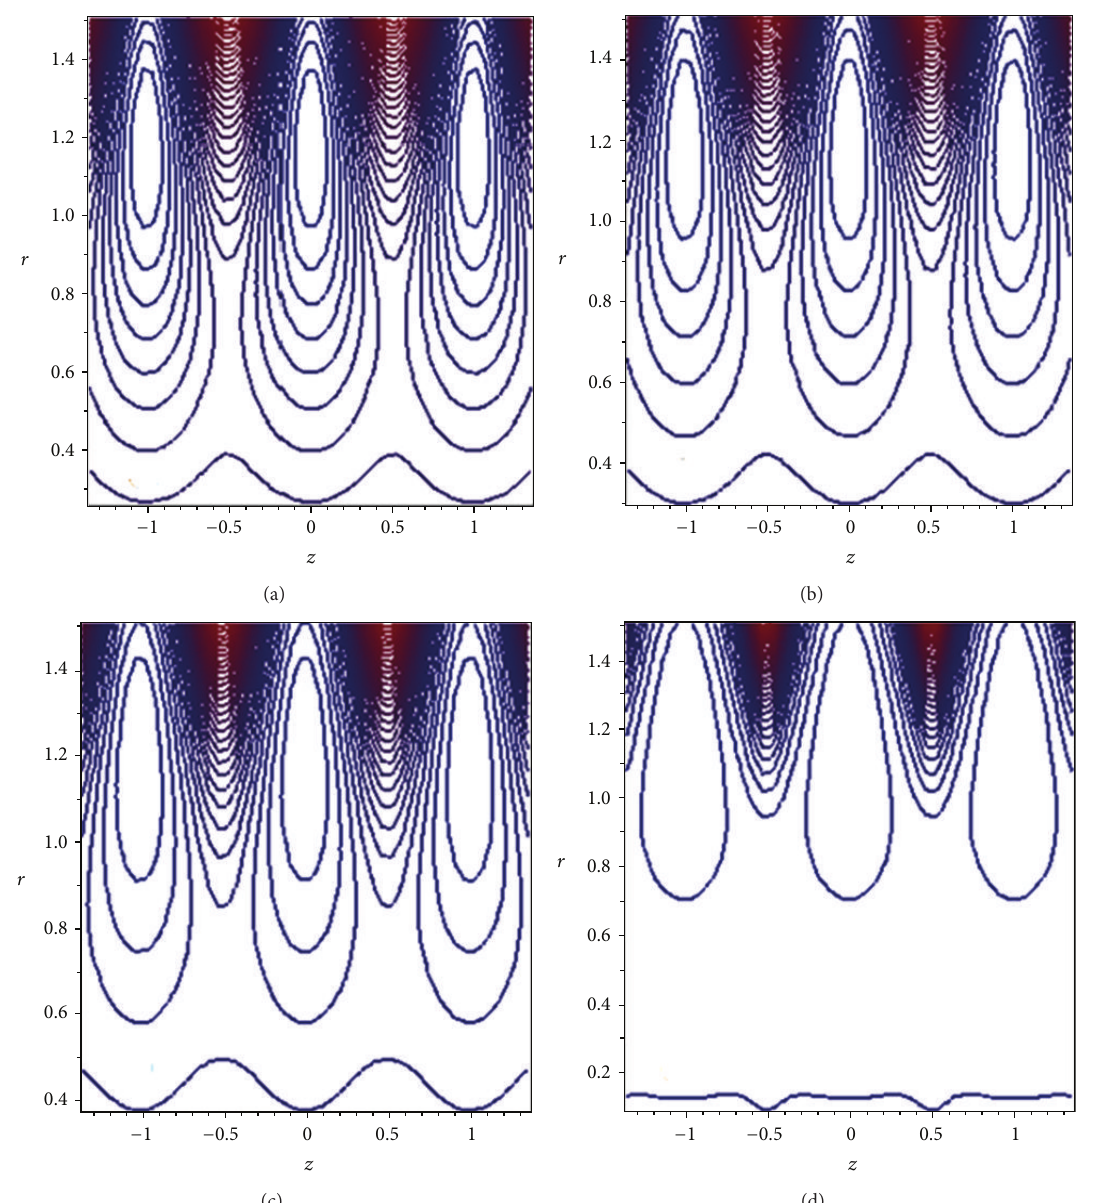
Figure 10: Streamlines for (a) 𝐻 𝑝 = 0.0 , (b) 𝐻 𝑝 = 0.01 , (c) 𝐻 𝑝 = 0.05 , and (d) 𝐻 𝑝 = 0.09 . The other parameters are 𝜀 = 0.25 , 𝛼 = 0.4 , 𝛽 = 0.4 , and 𝑄 = 0.95